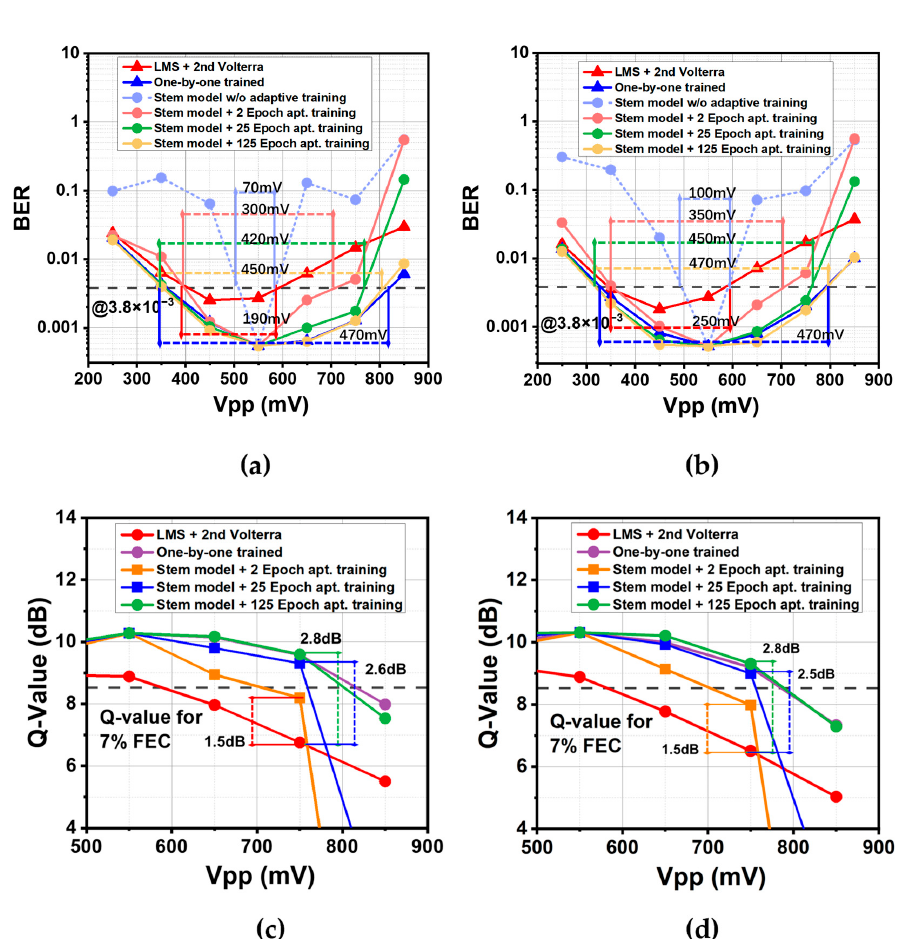
Figure 5. BER performance and Q-factor converted from BER. ( a ) BER curve for 64 QAM; ( b ) BER curve for 64 APSK; ( c ) Q-Value for 64 QAM; ( d ) Q-value for 64 APSK. curve for 64 APSK; ( c ) Q-Value for 64 QAM; ( d ) Q-value for 64